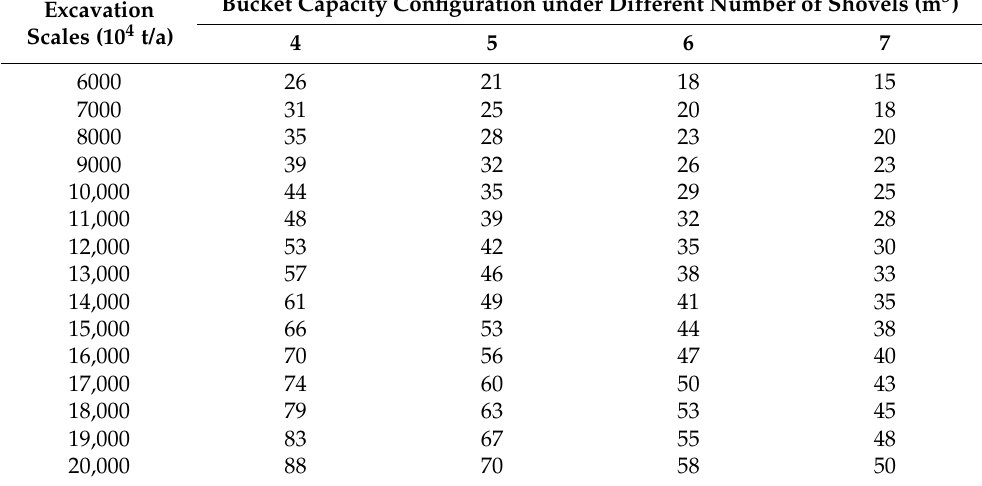
Table 3. Bucket capacity configuration for different excavation